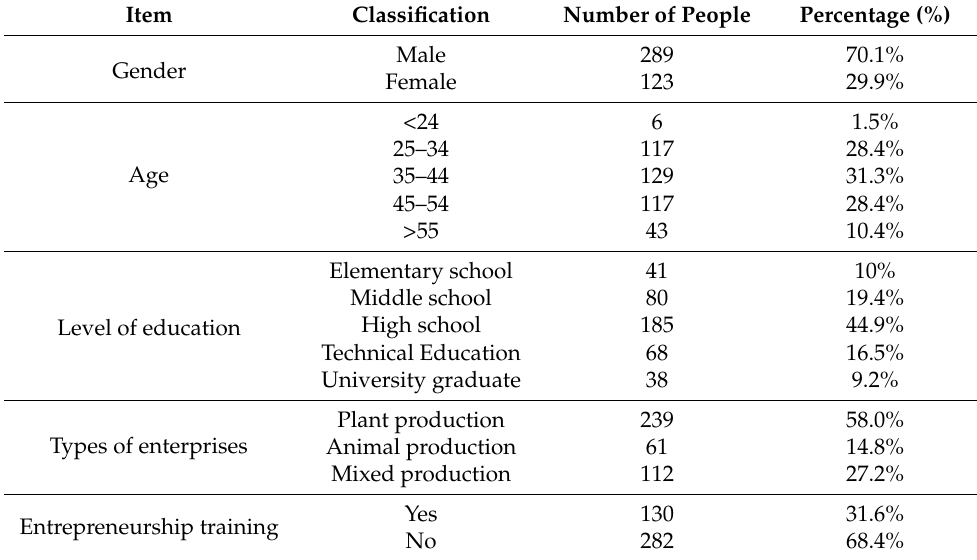
Table 2. The profile of the samples.